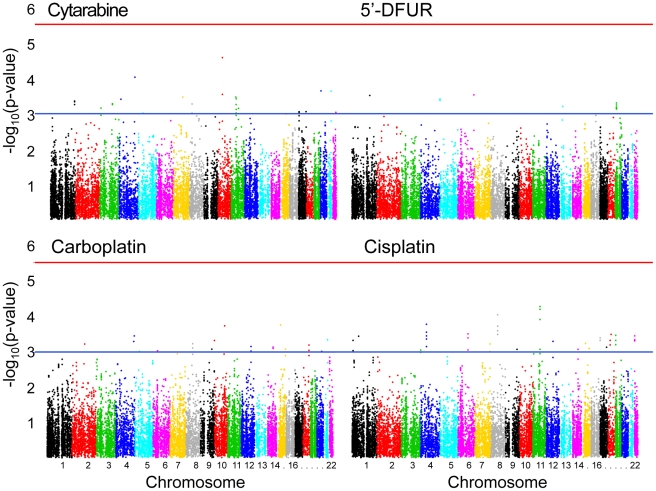
Gene-based genome-wide association results for chemotherapeutic-induced cytotoxicity in the ASW.Each point represents a gene. Blue lines are at the suggestive significance threshold of p = 10−3. Red lines are at the Bonferroni-adjusted genome-wide significance threshold of p = 2.8×10−6 for 17,723 tests.